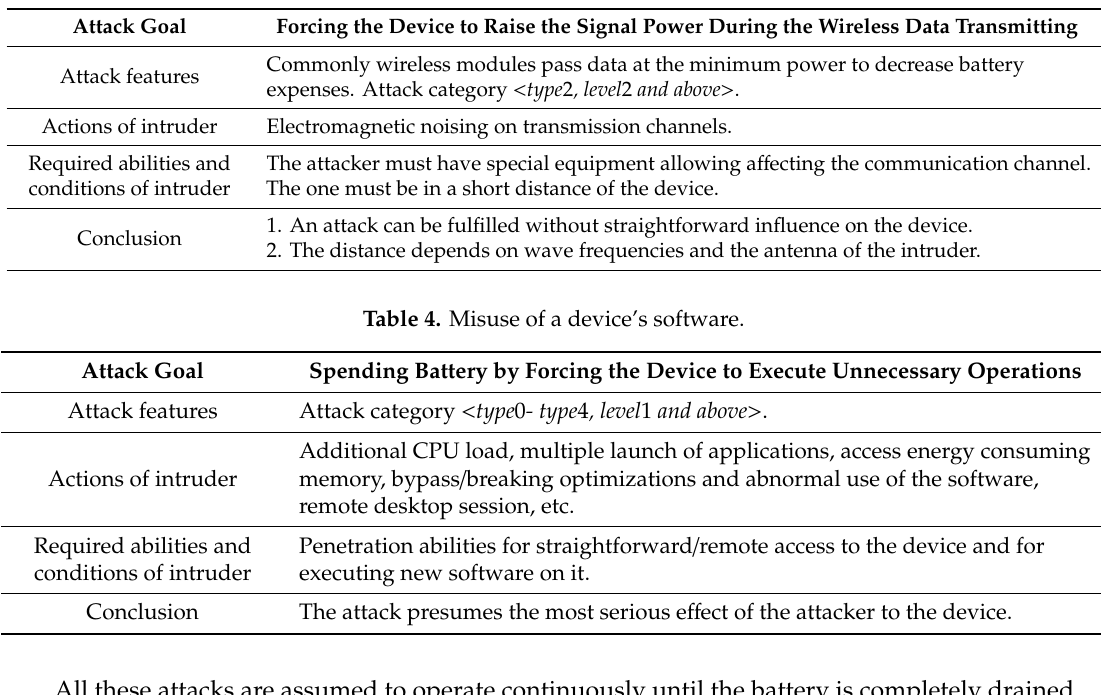
Table 3. Forming electromagnetic interference on wireless channels (jamming).